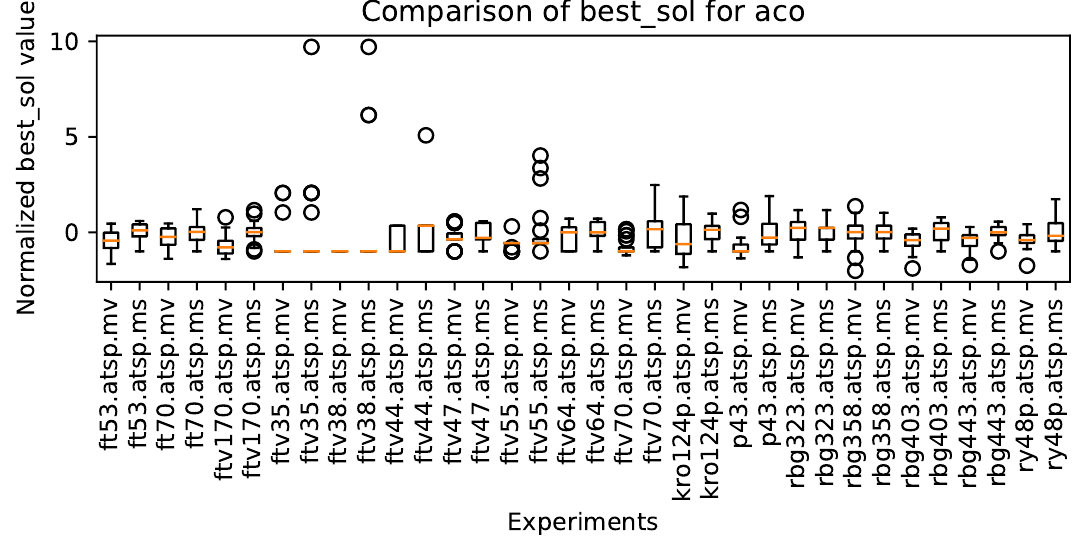
Figure 2. Boxplot of best cost achieved across the 25 runs for each instance problem using Multistart and Multiverse Ant Colony Optimization. Costs are normalized to the corresponding average using Multistart so that they are